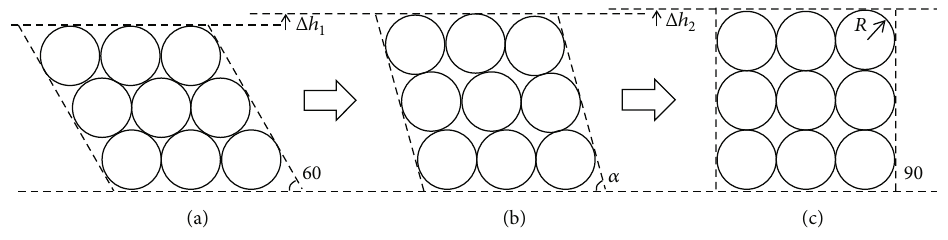
Figure 7: Two-dimensional evolutions of particle packing in the